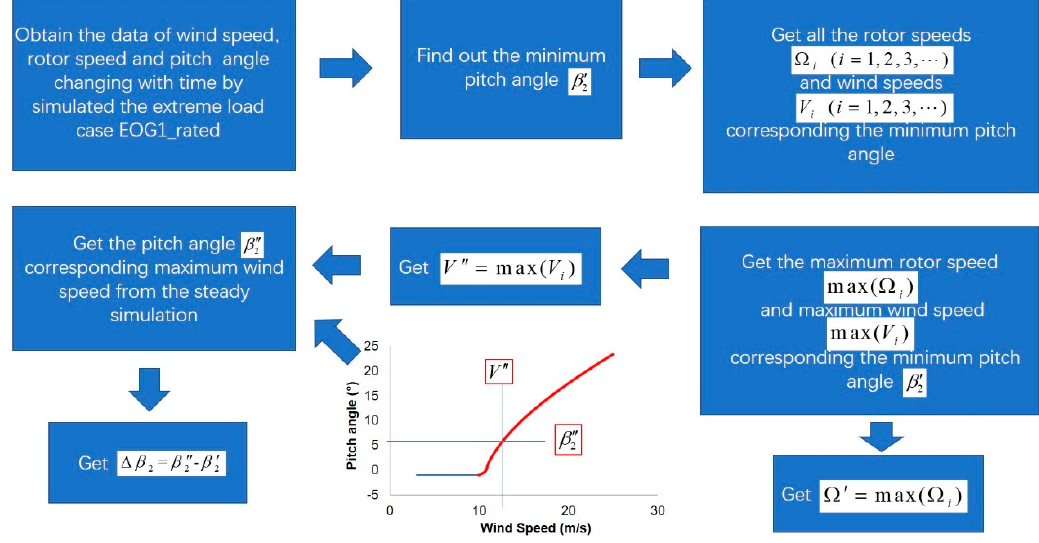
Figure 5. Calculation method of ∆ β 2